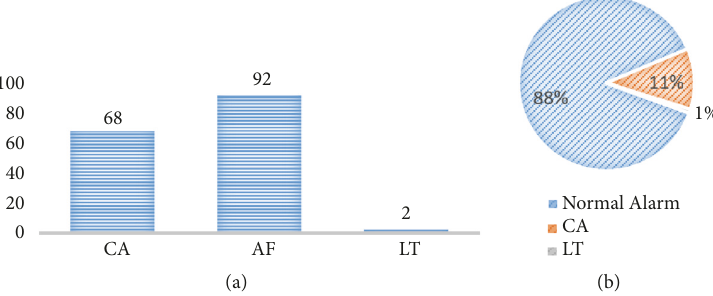
Figure 6: (a) The left side is the Number of CA, AF, and LT tasks. (b) shows the ratio of normal alarms, CA, and LT.